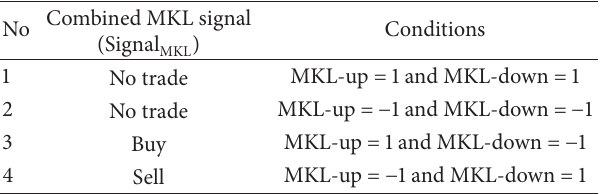
Table 3: Conditions for issuing the MKL signal.